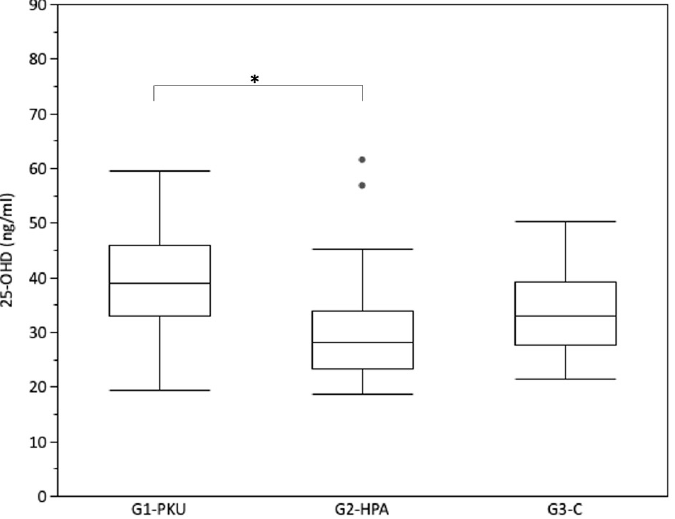
Figure 1. Plasma concentration 25-OHD (ng/mL) in each group. Plasma 25-OHD concentration in three groups of patients: Group 1: PKU, Group 2: HPA and Group 3: Control (n = 48). Groups were compared by Kruskal-Wallis test. The horizontal middle line represents the median and 95% confidence interval (CI). Significant difference between groups at p <0.05. A significant difference is observed between G1-PKU and G2-HPA,